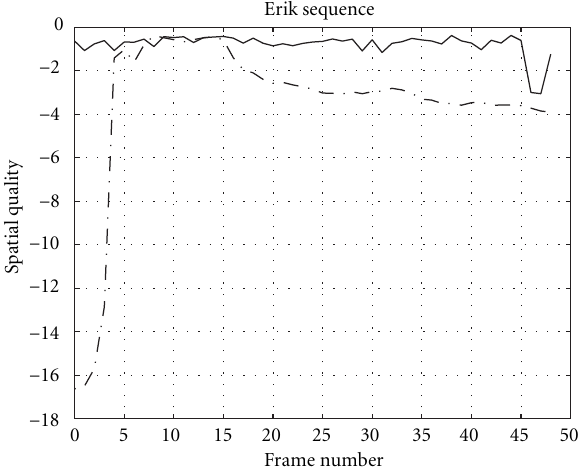
Figure 8: Comparison based on the spatial quality measure for the Erik sequence.